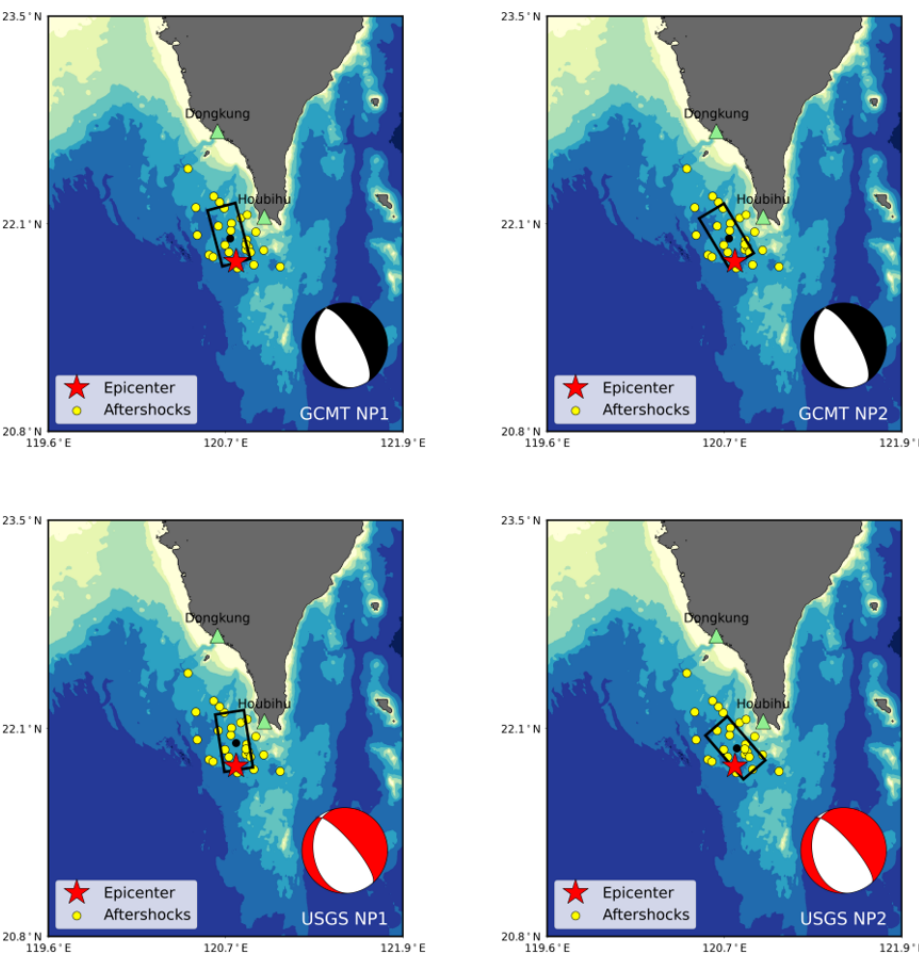
Figure 15. Simple fault models of the first earthquake ( M w 7.0) using the focal mechanisms from GCMT and USGS. The green triangles indicate the tide gauge stations, red stars indicate the epicenter, yellow circles indicate aftershocks, and the black rectangles indicate the fault